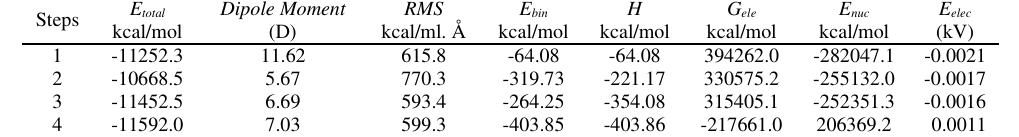
Table 2: The structural and thermodynamic properties of closed nitrate ions to different positions of zinc oxide nano-cage at 298K. Figure 2: a) the different positions of closed nitrate ion to Zn 12 O 12 nano-cage and b) the molecular electrostatic potential surface Zn 12 O 12